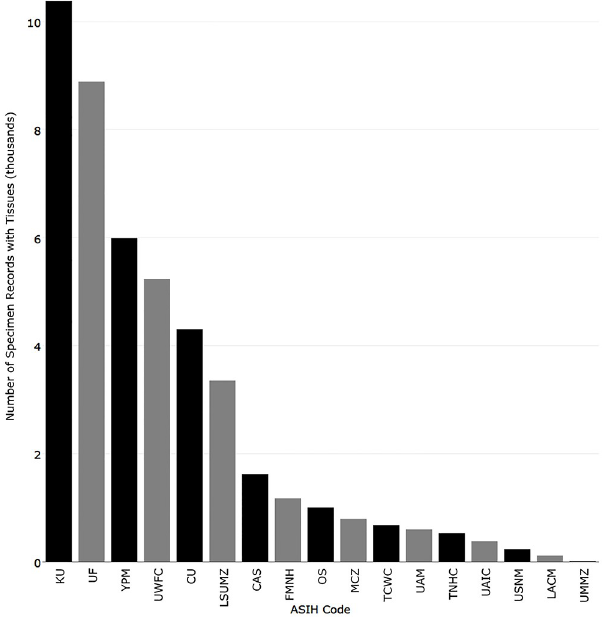
Fig 15. Number of records published in iDigBio with at least one tissue associated with a record.